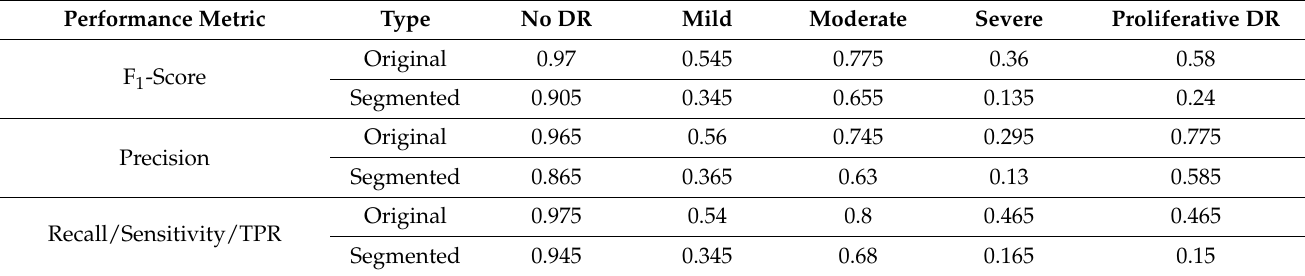
Table 4. F 1 Score, Precision, and Recall/Sensitivity/TPR for original and segmented blood vessels for DR severity